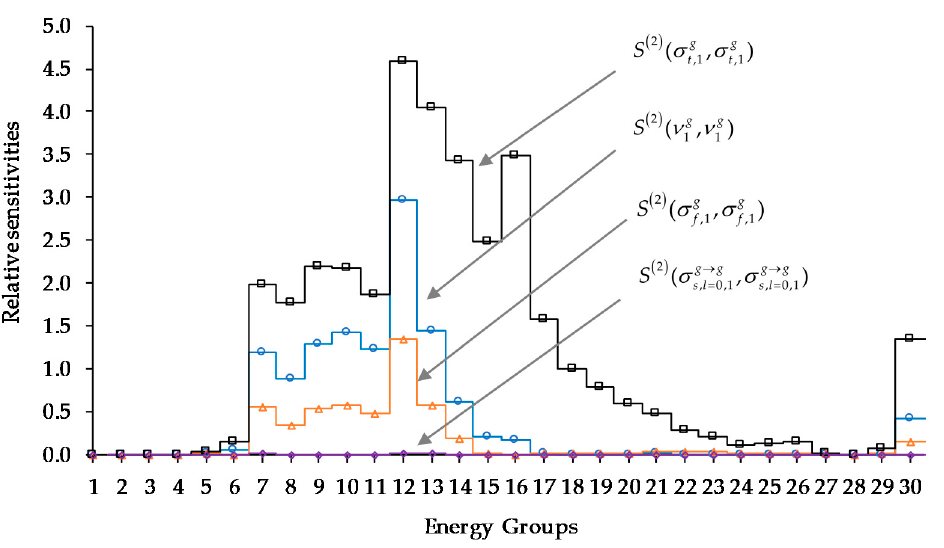
Figure 3. Comparison of second-order relative sensitivities for isotope 1 ( 239 Pu).